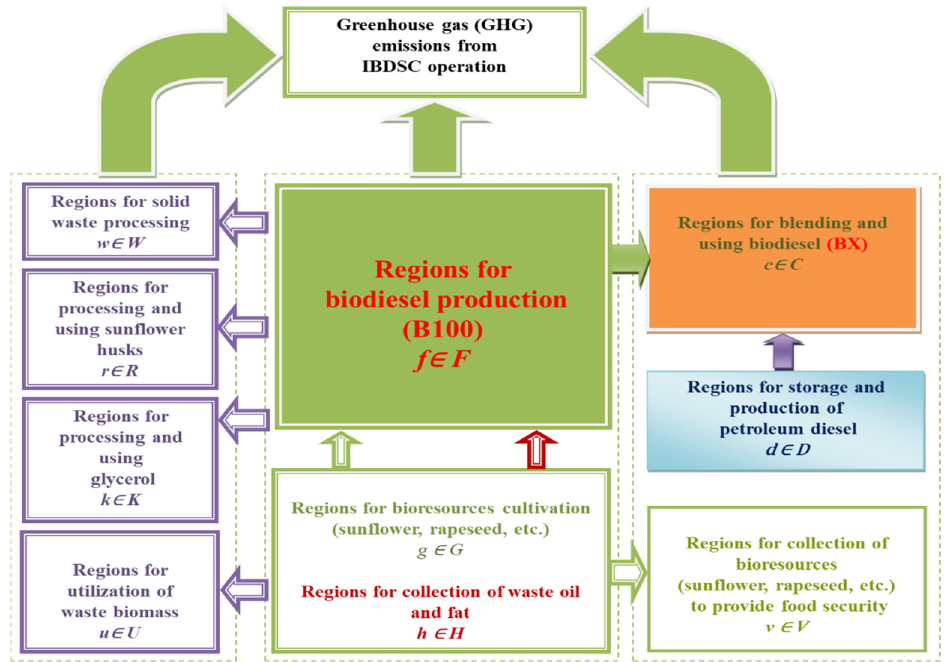
Figure 1. Superstructure of the integrated biodiesel/diesel supply chain.